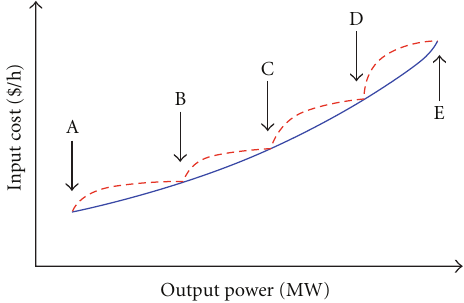
Figure 1: Example input-output curve with five valve points. A–E: Operating points of admission